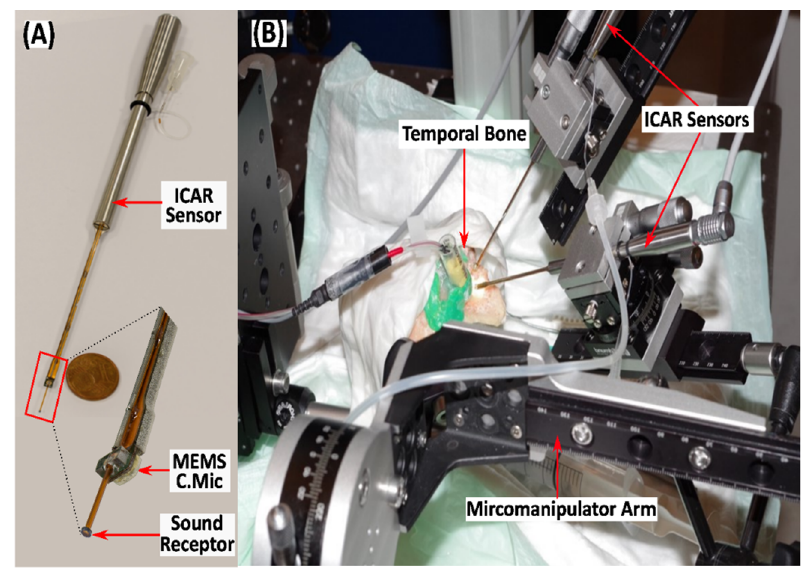
Figure 1. ( A ) Custom-made intracochlear acoustic receiver (ICAR) sensor with a zoomed view on the sound receptor and micro-electromechanical system (MEMS) condenser microphone. ( B ) Experimental setup with a human temporal bone (HTB) sample, artificial ear canal (AEC), and two ICARs for simultaneous pressure measurement in SV and ST. For a precise sensor insertion into the cochlea, both hydrophones are positioned using multi-axis micromanipulator units.